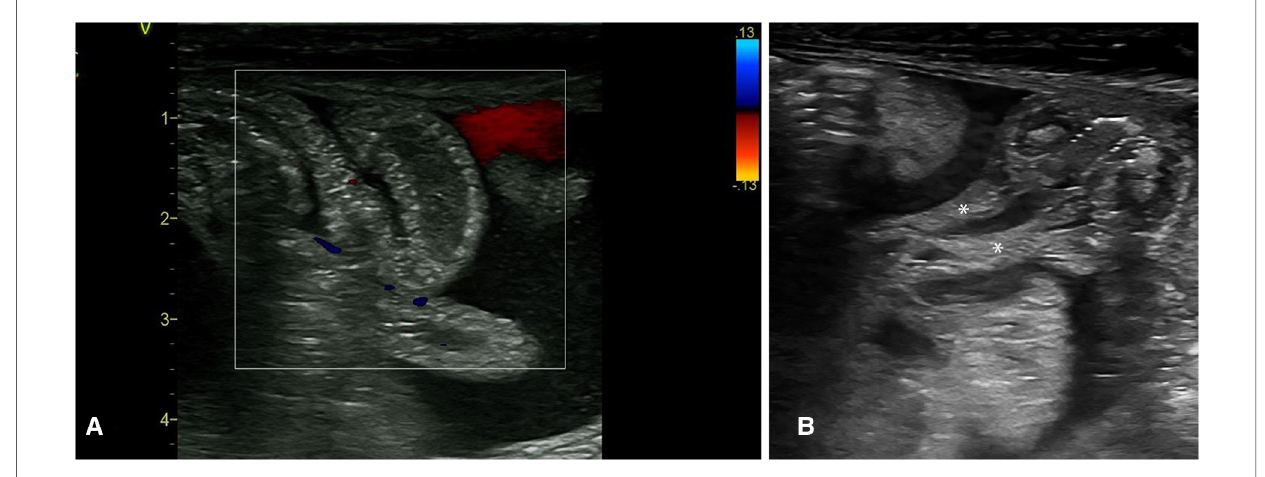
FIGURE 10 The sonographic appearance of the intra-abdominal complex fl uid collections seen in necrotizing enterocolitis. ( A ) Thickened bowel loops fl oating within the fl uid with echogenic foci (complex ascites). ( B ) Thickening of the omentum as seen within this complex fl uid. * Thickened omentum.